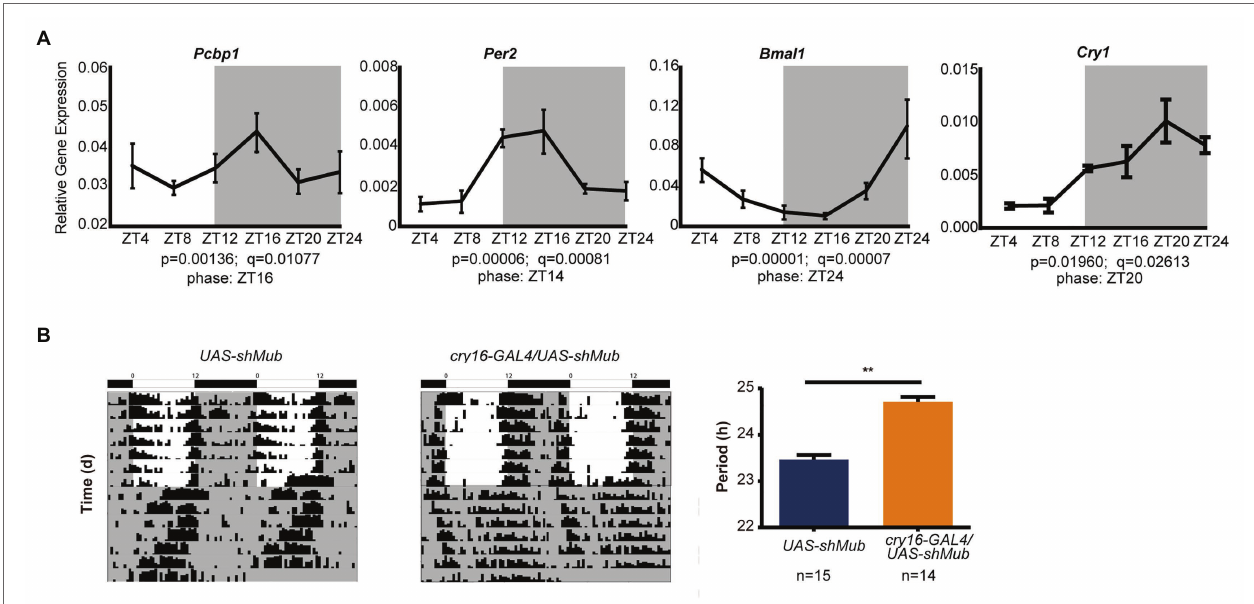
FIGURE 4 | The ability of PCBP1 to regulate circadian rhythm is conserved in evolution. (A) The expression of the PCBP1 gene is rhythmic in the mouse heart. The phase of PCBP1 is ZT16, which is similar with PER2 (ZT14) and CRY1 (ZT20), but contrary to BMAL1 (ZT24). All data are presented as the mean ± SEM from at least four independent experiments. The qPCR data were analyzed by JTK_Cycle analysis to determine the rhythmicity and the phases of the peaks (time course threads with both p and q values less than 0.05, were considered as rhythmic). (B) Drosophila with conditional knockdown of mushroom-body expressed ( mub ), the homolog gene of PCBPs in Drosophila , in circadian neurons show a period-lengthening circadian rhythm (middle) compared to wild-type (left). Right: Bars show quantitative period change values Statistical significance was determined using Student’s t -tests ( n ≥ 14, ** p <